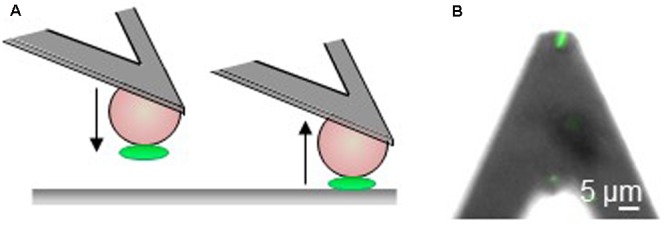
The use of a microbead for single-cell force spectroscopy analysis. (A) Principle of single cell force spectroscopy with tip less cantilevers modified with colloidal beads and coated with polydopamine to attach a single bacteria (green) and probe it toward surfaces. (B) Optical microscope image of a single bacterium attached to the colloidal cantilever probes documenting that the cell is properly located and alive (green fluorescence).